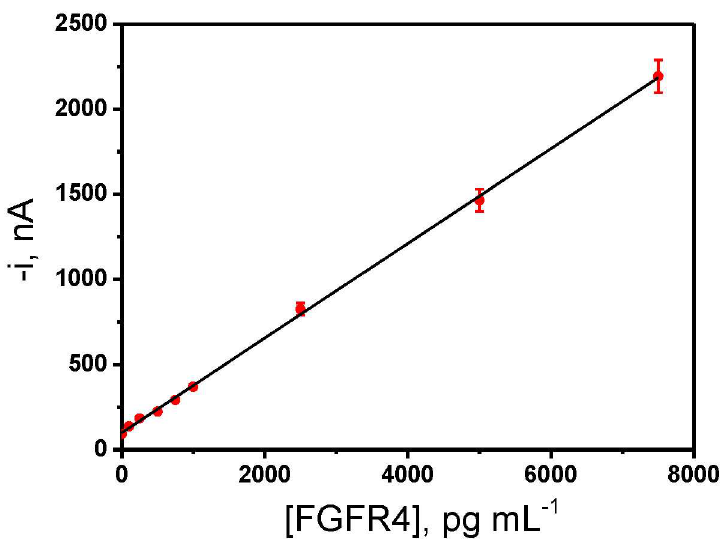
Fig 3. Dependence of the amperometric response measuredwith the developed magnetic immunocarriers-basedsensor with the concentration of FGFR4 standards. Error bars estimated as triple of the standarddeviation(n =